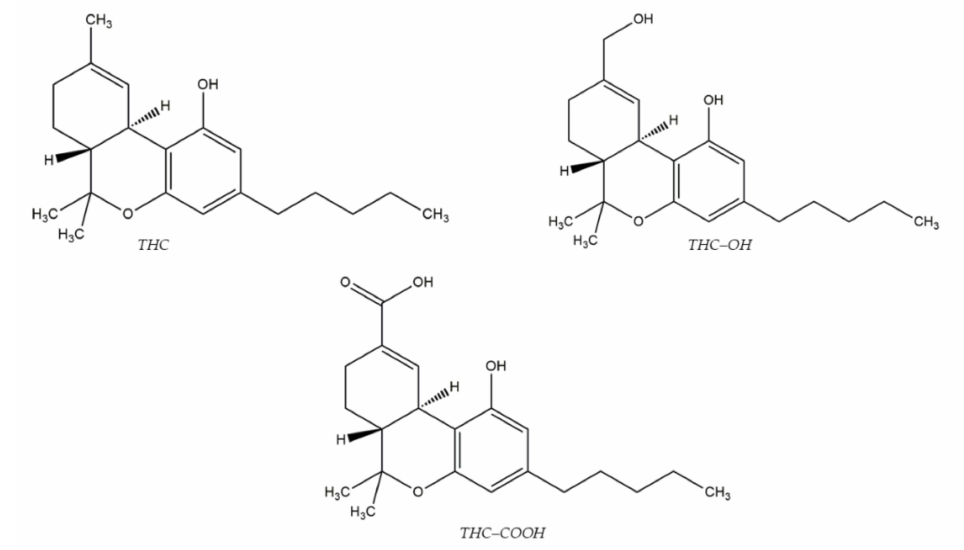
Figure 3. Chemical structures of ∆ 9-tetrahydrocannabinol (THC), 11-hydroxy- ∆ 9-THC (THC-OH), and 11-nor- ∆ 9-THC-9-carboxylic acid (THC-COOH). Biological post-mortem samples include urine, stomach contents, and bile, pretreated